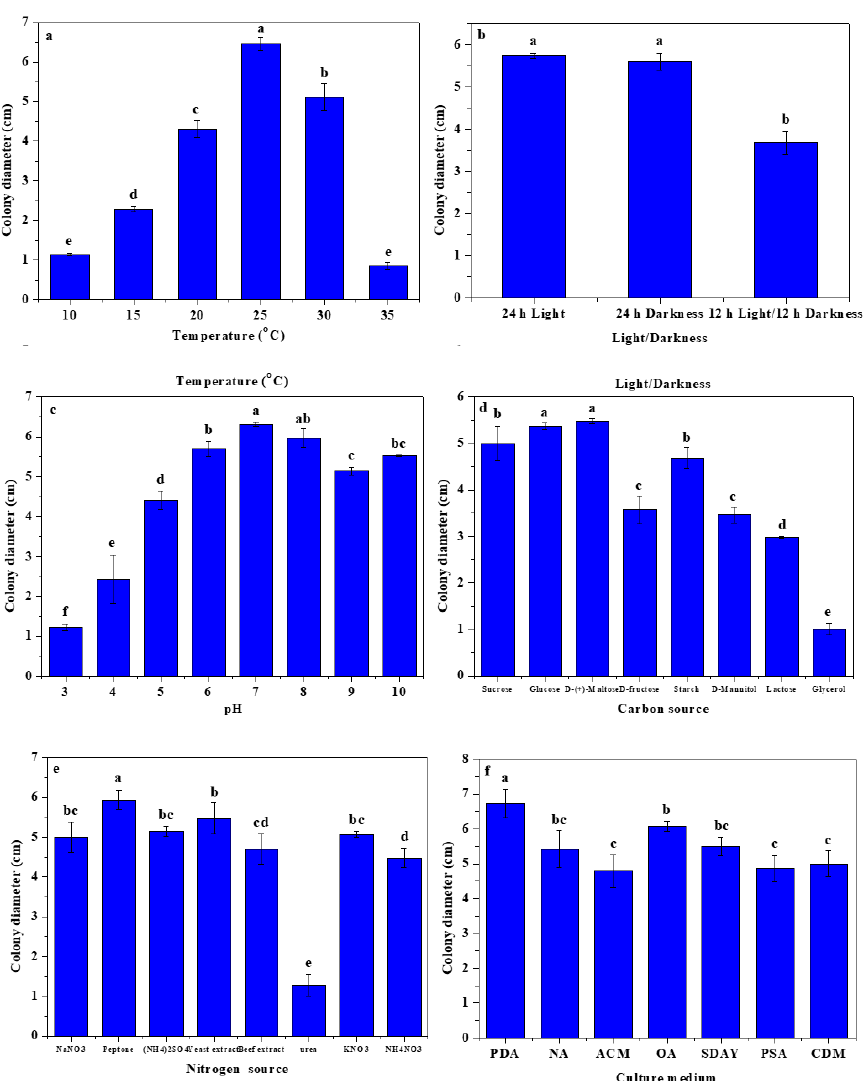
Figure 5. The effects of temperature ( a ), light ( b ), pH values ( c ), carbon sources ( d ), nitrogen sources ( e ), and culture media ( f ) on the growth of strain CXCDF-3. Values and error bars indicate the mean and SD of four replicates, respectively. Different small letters indicate significant differences at the 5% level ( p < 0.05).